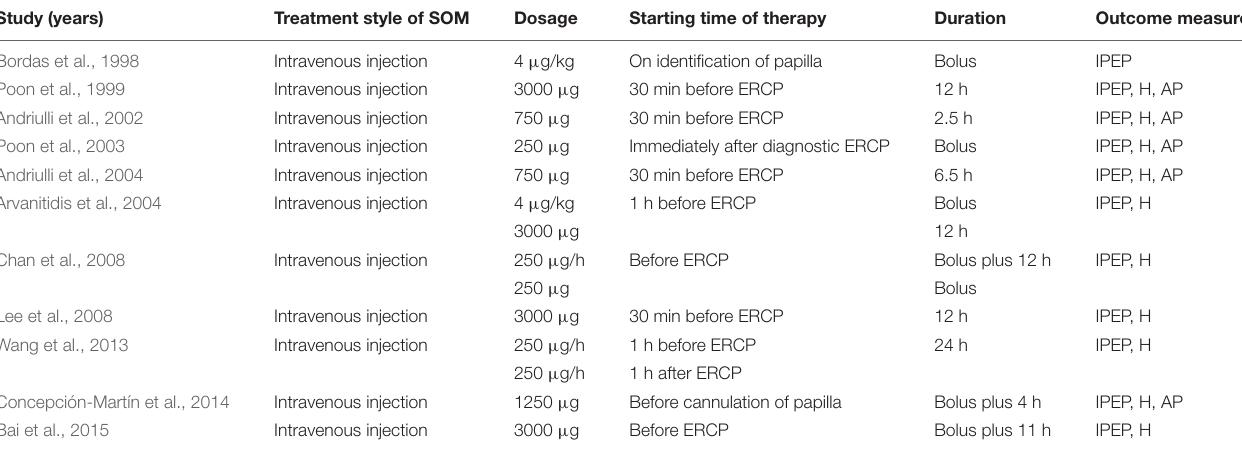
FIGURE 1 | Flow diagram of eligible articles selection process. TABLE 1 | Intervention in 11